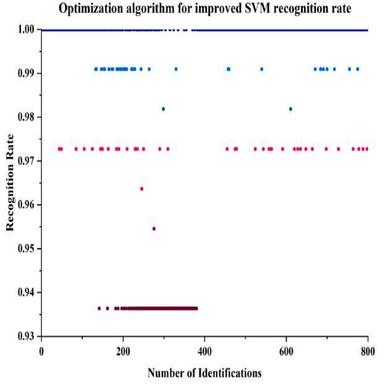
Actual classification diagram and predicted classification diagram of the test data set.